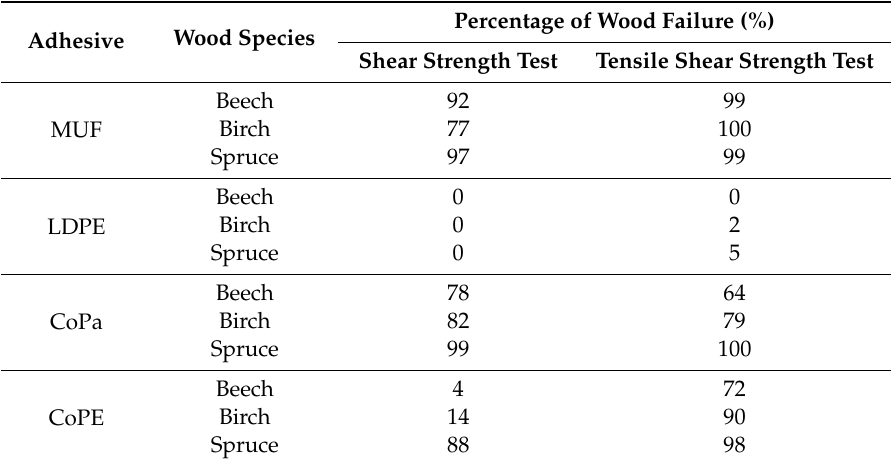
Table 3. Wood failure percentage of plastic-bonded plywood